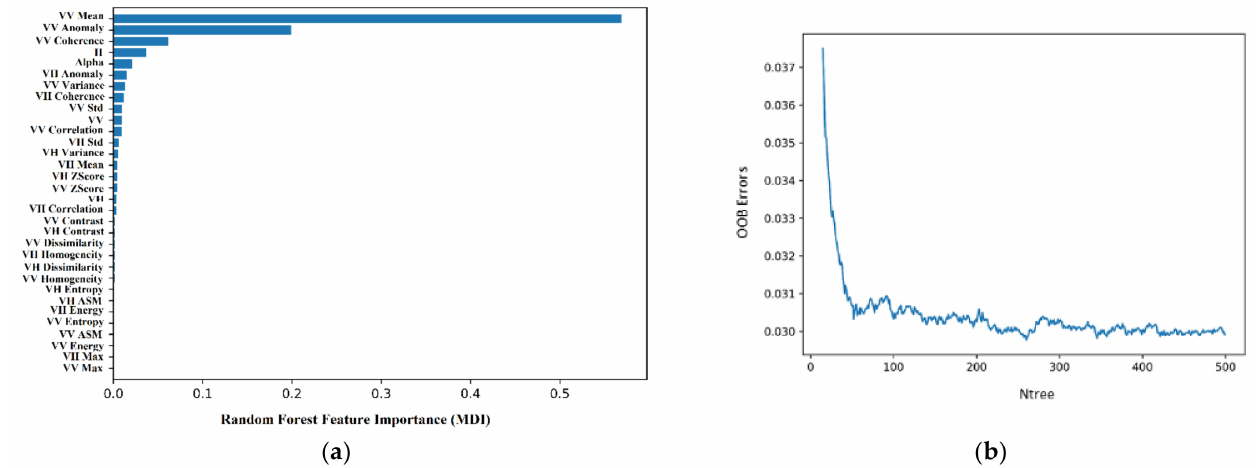
Figure 8. ( a ) Random Forest feature importance based on MDI for SAR-derived features, and ( b ) OOB error vs. number of trees for the best six SAR-derived features (event 2017).